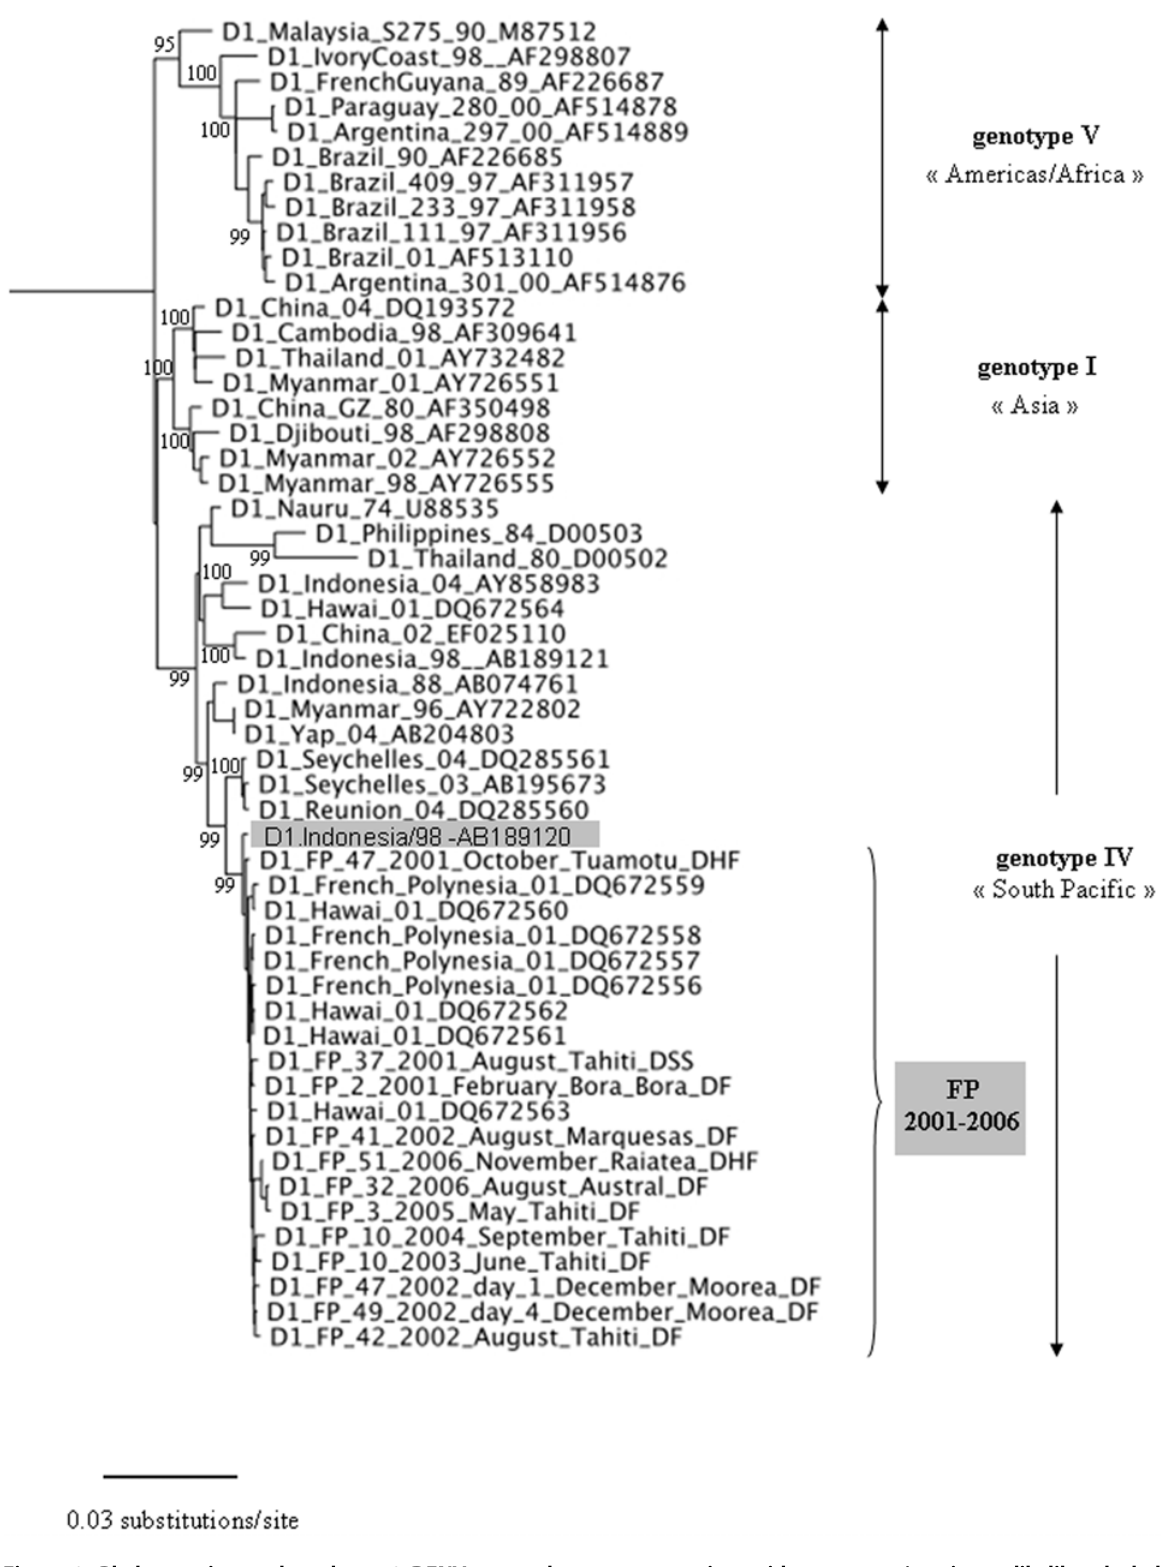
Figure 3. Phylogenetic tree based on 53 DENV-1 complete genome amino acid sequences (maximum likelihood phylogenetic analysis using Bayesian method). Taxon names of FP sequences correspond to D1_FP_sample number_year_month_geographical origin_clinical presentation. Taxon names of GenBank sequences correspond to D1_country_last two digits of year of isolation_GenBank accession number. Posterior probabilities (percent) are shown for values . 80 only. All horizontal branch lengths are drawn to a scale of substitutions per site. The tree was rooted using a DENV-3 strain (D3_SriLanka_00_NC001475, not shown for purposes of clarity only).